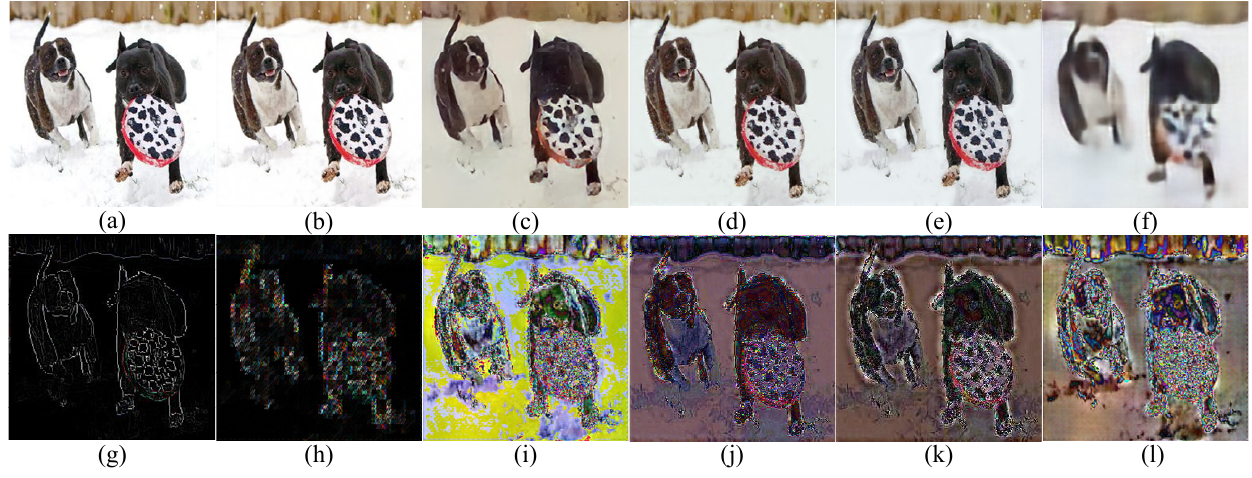
Figure 13. Comparison of the IR results for different algorithms: ( a ) original image; ( b ) proposed algorithm; ( c ) Ref [4]; ( d ) Ref [1]; ( e ) Ref [3]; ( f ) Ref [32]; ( g ) multiscale interest points feature maps of ( a ); ( h ), ( i ), ( j ), ( k ), and ( l ) are the difference images of |( a ) − ( b )| × 5, |( a ) − ( c )| × 5, |( a ) − ( d )| × 5,